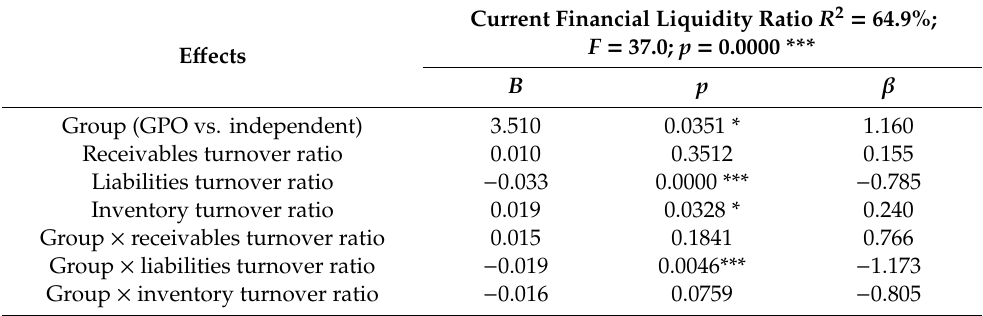
Table 7. Results for regression model with current financial liquidity ratio as dependent